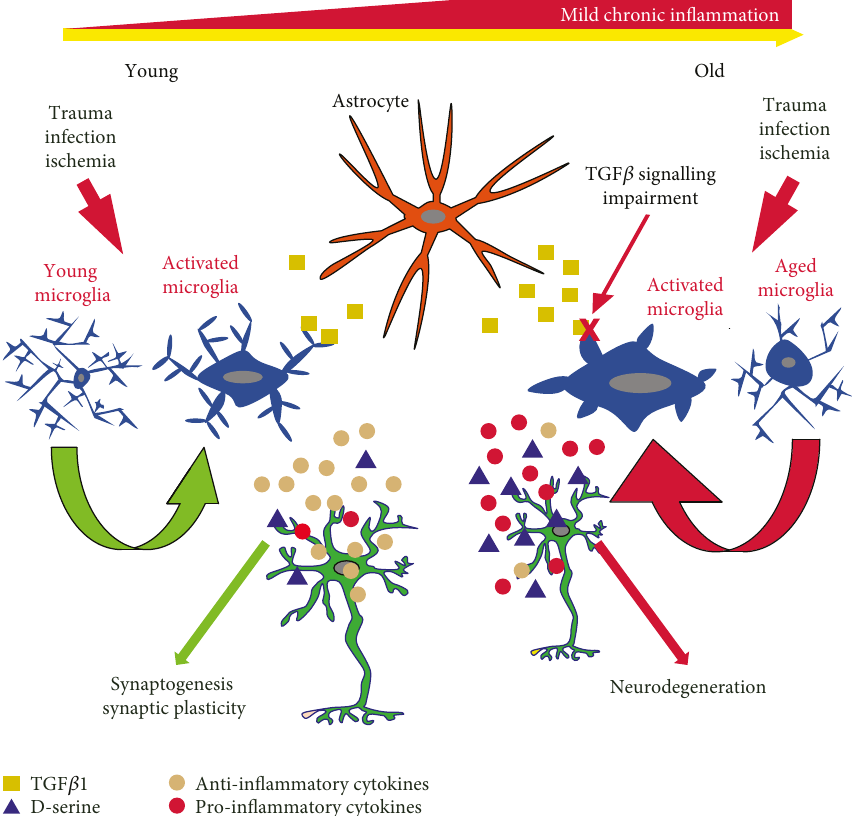
Figure 2: Impact of aging in microglial function and release of D-serine. In aging, a mild chronic in fl ammation promotes dysfunction of microglia and their cytotoxic activation. In contrast to young microglia, aged microglia show changes in TGF β 1-Smad signaling that promote an in fl ammatory microglial phenotype. They release decreased levels of anti-in fl ammatory cytokines and high levels of proin fl ammatory cytokines and D-serine. The in fl ammatory environment together with increased levels of free D-serine could induce impairment in synaptogenesis and synaptic plasticity and contribute to